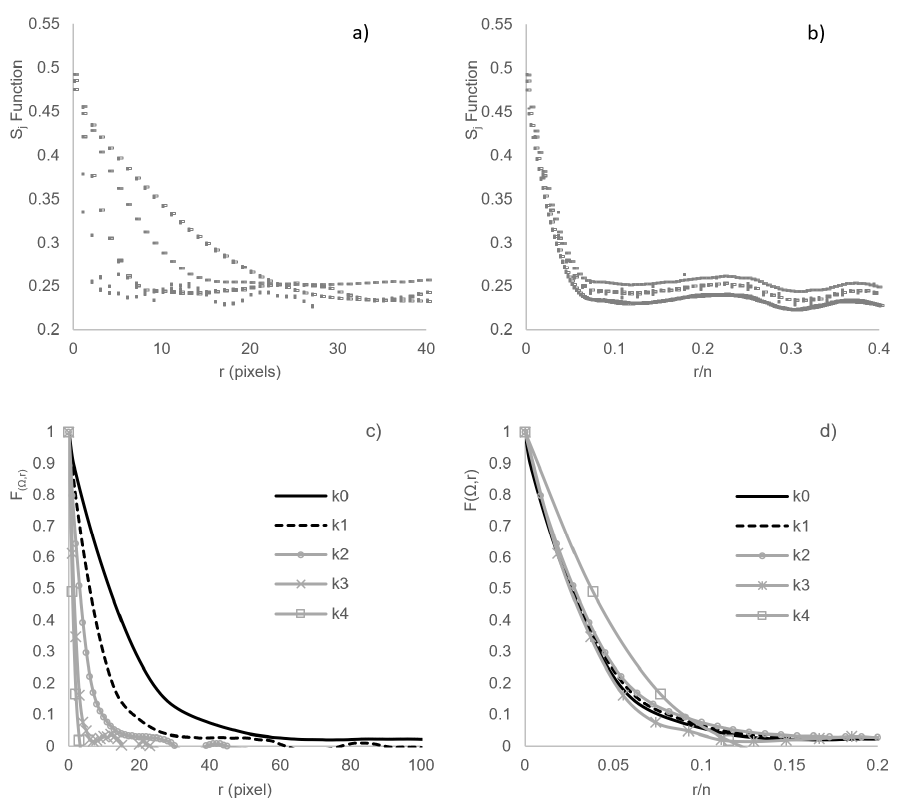
Figure 4. S j correlation function and F ( Ω , r ) average for all ω realizations of every configuration of the S50 Figure 4. 𝑆 correlation function and 𝐹 (cid:3037) the S50 image.